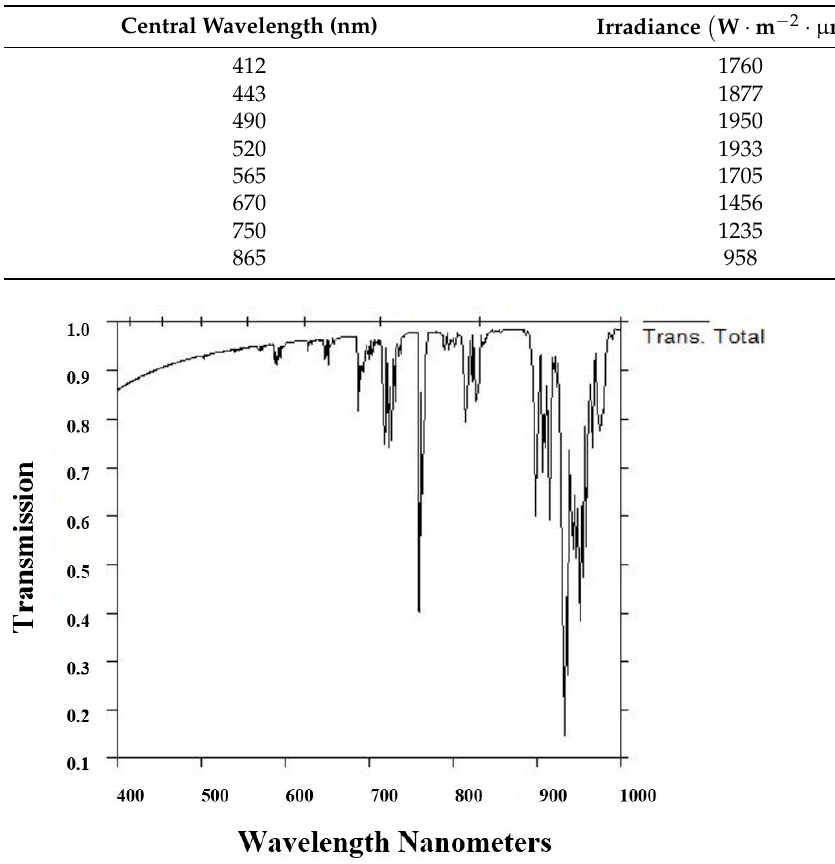
Table 2. The solar irradiance outside the atmosphere in different bands.